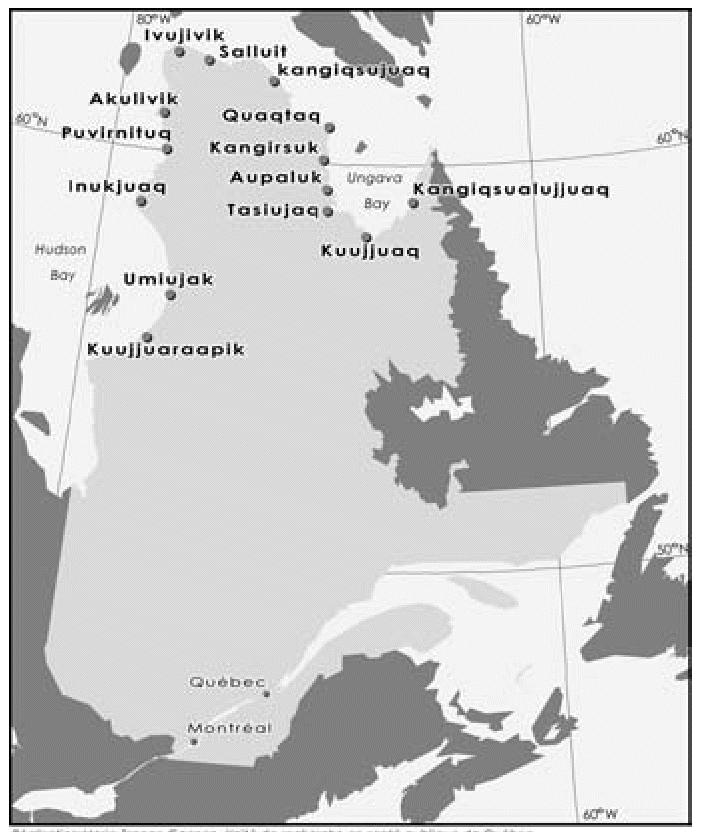
Location of Inuit communities in Nunavik (province of Québec, Canada).